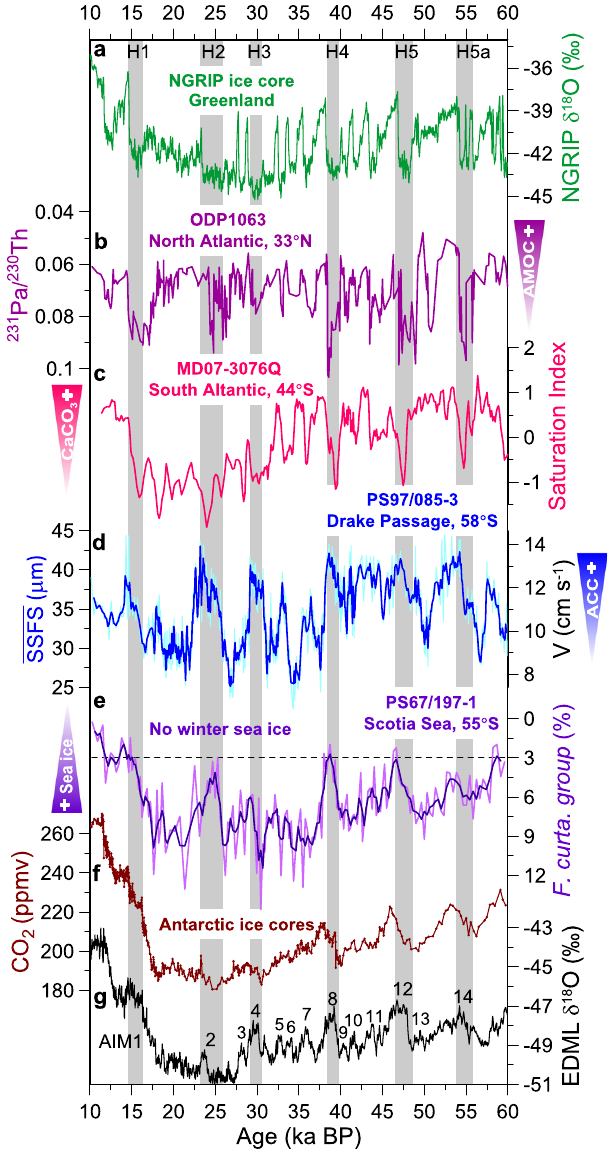
Fig. 4 Millennium-scale changes in ACC strength compared to paleoclimatic records over the last 60 ka. a Oxygen isotope record from North Greenland Ice Core Project (NGRIP, δ 18 O vs. VSMOW) 70 . b Bermuda Rise 231 Pa/ 230 Th proxy for the AMOC strength 44,59,60 . c Saturation index as a proxy for reconstructed carbonate saturation changes in the South Atlantic 49 . d SSFS as fl ow speed proxies for the current strength (three- point smoothing, this study) and the transferred ACC fl ow speeds. e Relative abundance of diatom winter sea ice indicator Fragilariopsis curta group ( F. curta + F. cylindrus ) with three-point smoothing 22,67 . The group abundance >3% indicates the presence of winter sea ice 22,67 . f Synchronized ice-core atmospheric p CO 2 45 . g δ 18 O time series from the EDML ice core 45 . Vertical gray bars mark inferred millennial-scale ACC peaks that correspond with millennial-scale temperature maxima in Antarctica (AIM) and Heinrich events (H) in